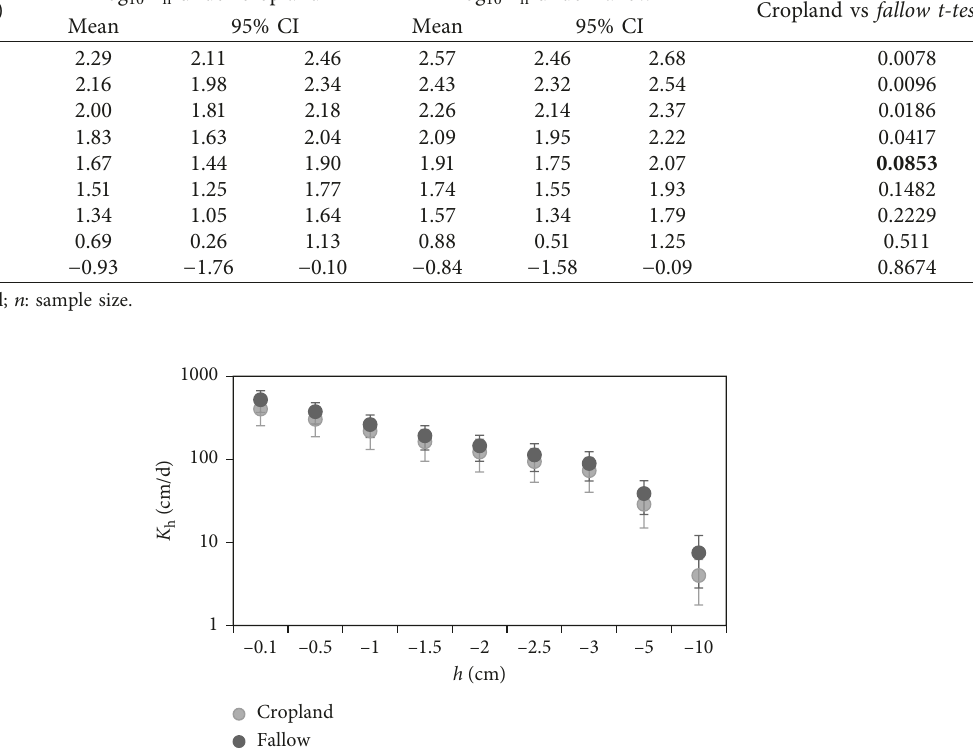
Table 3: Summary of statistics for the log Water tension (cm)